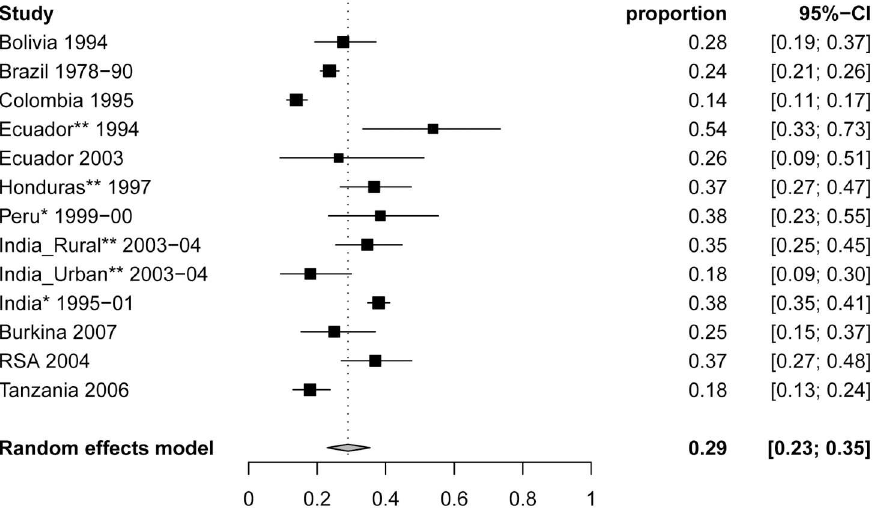
Fig 2. Forest plots of the proportion of NCC (95% CI) in people with epilepsy from 12 studies reporting from cases in all age groups. * Indicatesstudies among peoplewith epilepsyand seizures. ** Indicates studies amongpeoplewith active epilepsyonly. The figure, title and legendwere taken from Figure 4 in [5] (http://dx.doi.org/10.1371/journal.pntd.0000870.g004). No changeswere made to the originalfigure, title and legendin